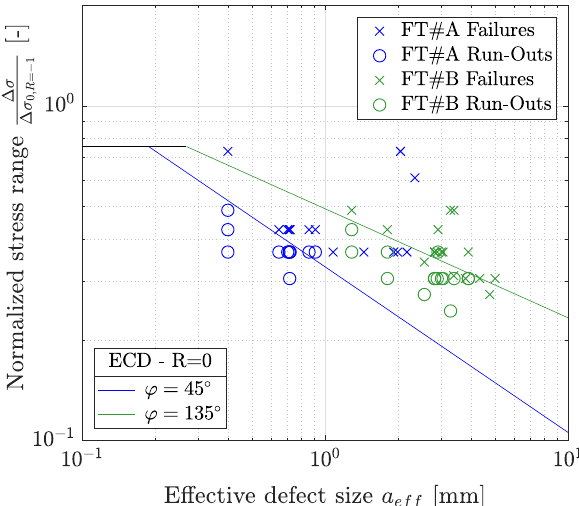
Figure 21. Generalized Kitagawa diagram (GKD) assessment of afflicted specimens at R = − 1 stress ratio with a cut-off fatigue life of 10 7 , where the defect size is based on fracture surface analysis.